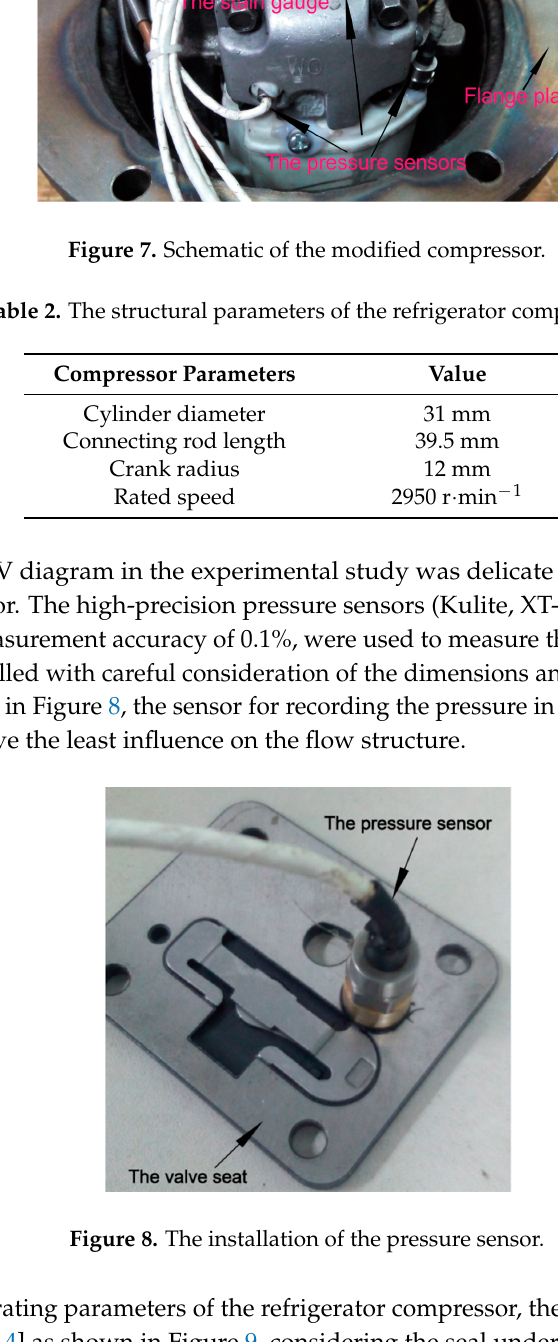
Figure 8. The installation of the pressure sensor.